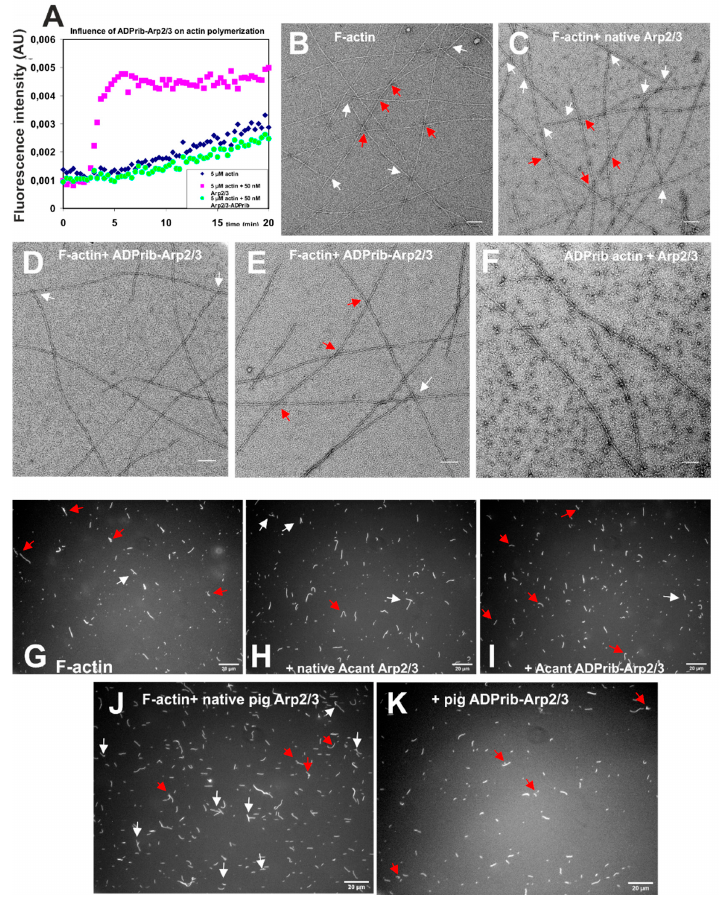
Figure 4. Properties of Arp2/3 complex after ADP-ribosylation of Arp2. ( A ) Pyrene-labelled actin (10%) was used to test the nucleating activity of native Arp2/3 before and after Arp2 ADP-ribosylation. Polymerization of 5 µ M skeletal actin was initiated by addition of 2 mM MgCl 2 in the absence or presence of 50 nM Arp2/3 complex. Note the absence of nucleating activity of Arp2/3 treated with His-tagged CDTa component for 4 h. The CDTa was removed by Ni-NTA-beads and further gel filtered to additionally remove its substrate NAD. Ordinate gives fluorescence intensity in arbitrary units (AU) ranging from 0 to 0.006; Abscissa gives time in min. ( B – F ) EM after negative staining of skeletal actin polymerized by 2 mM MgCl 2 in the absence and presence of native and modified Arp2/3. ( B ) F-actin alone; ( C ) in the presence of native and ( D,E ) of CDTa treated Arp2/3 complex, and ( F ) ADP-ribosylated actin in the presence of native Arp2/3 complex. Branches are marked by black and crossings by red arrows (B-E). Magnification: 20.000 fold; bars correspond to 100 nm. ( G – K ) Fluorescent images of TRITC-phalloidin stained 10 nM actin samples: ( G ) F-actin control, ( H ) plus Acant. castellani native Arp2/3 complex, ( I ) plus Acant. castellani Arp2/3 complex after ADP-ribosylation; ( J ) plus pig brain native Arp2/3 complex, and ( K ) plus pig brain Arp2/3 complex after ADP-ribosylation (for details see text). Bars correspond to 20 µ m; branches are marked by white and crossings by red